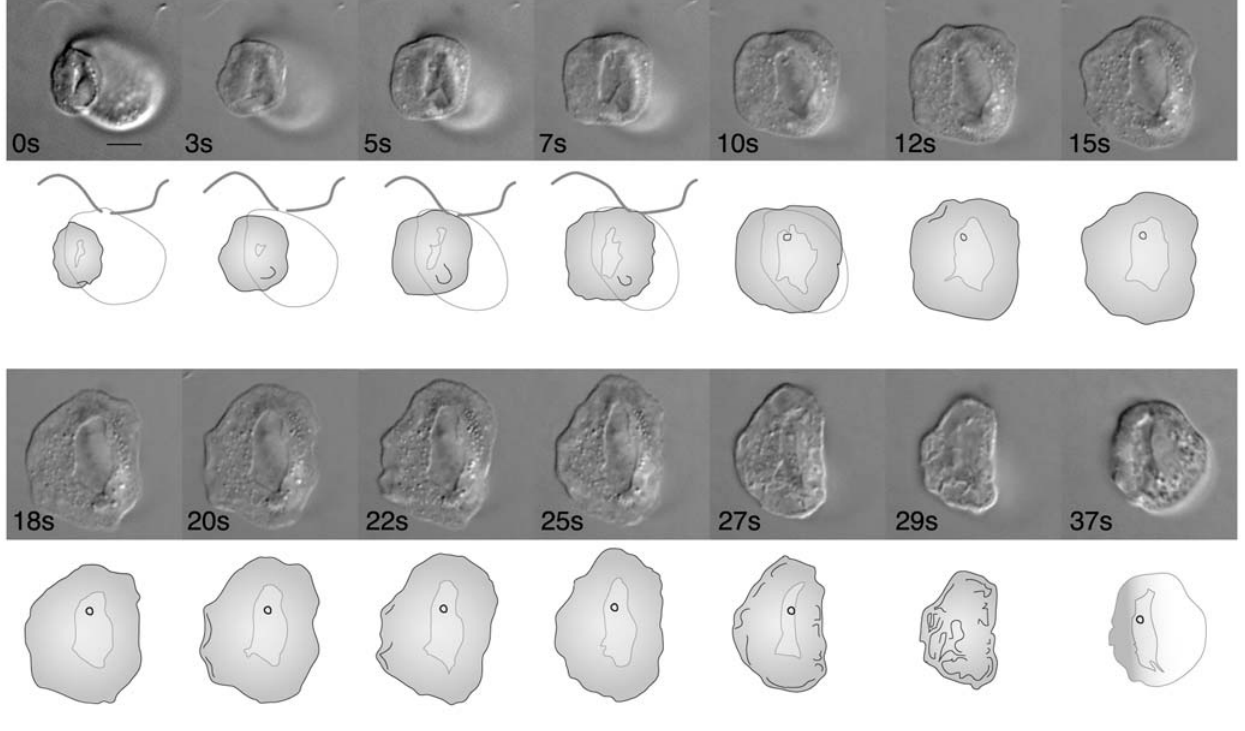
Figure 3. Feeding behavior on bacteria. Time in seconds from the beginning of the sequence is shown at the bottom left of each frame. The cell attaches to prey at the subapical region of the right lateral side ( 0 s ), where the cytoplasm becomes flexible and spreads on coverslip to trap a bacterial prey cell ( 5 s ). Once it is fully extended ( 25 s ), the margin of the thin layer of cytoplasm thickens and contracts as the cell quickly detaches from the surface ( 27 s – 29 s